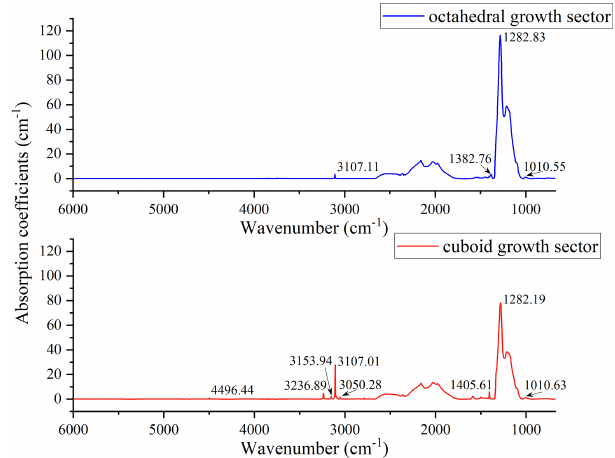
Figure 6. FTIR absorption spectra of different growth sectors in